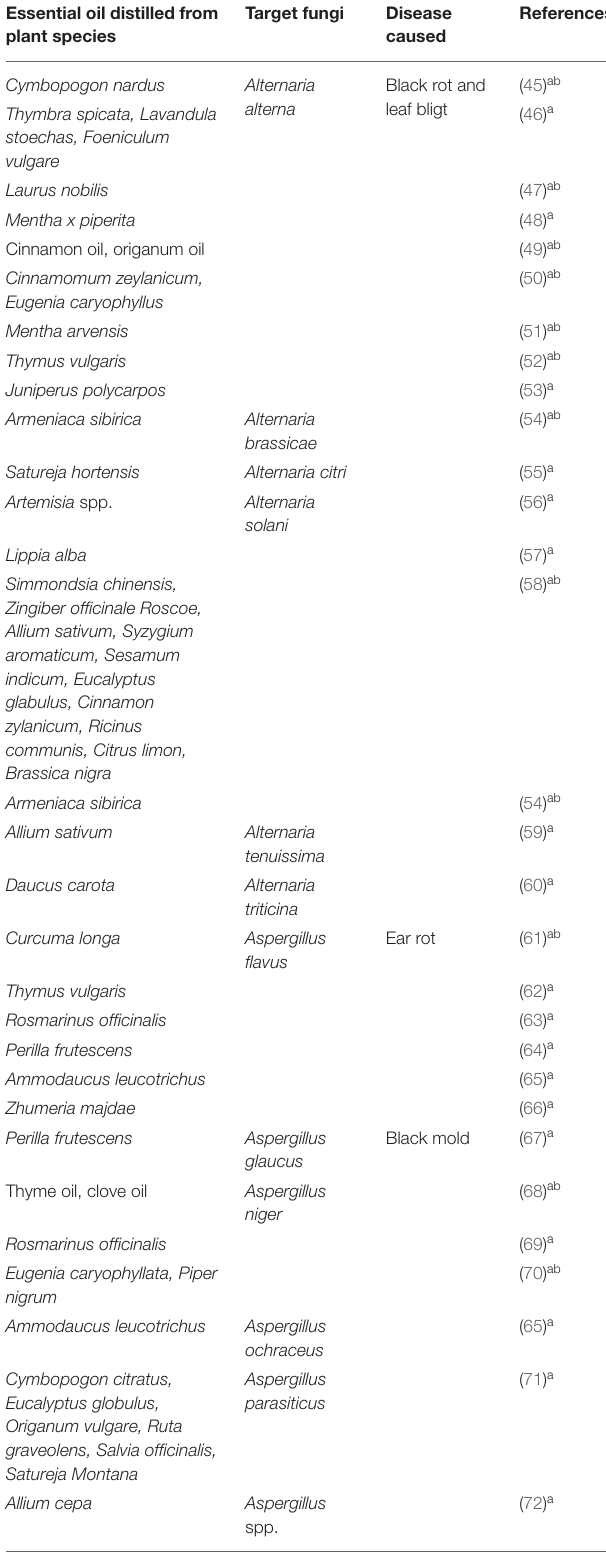
TABLE 1 | Examples of EOs acting against phytopathogenic